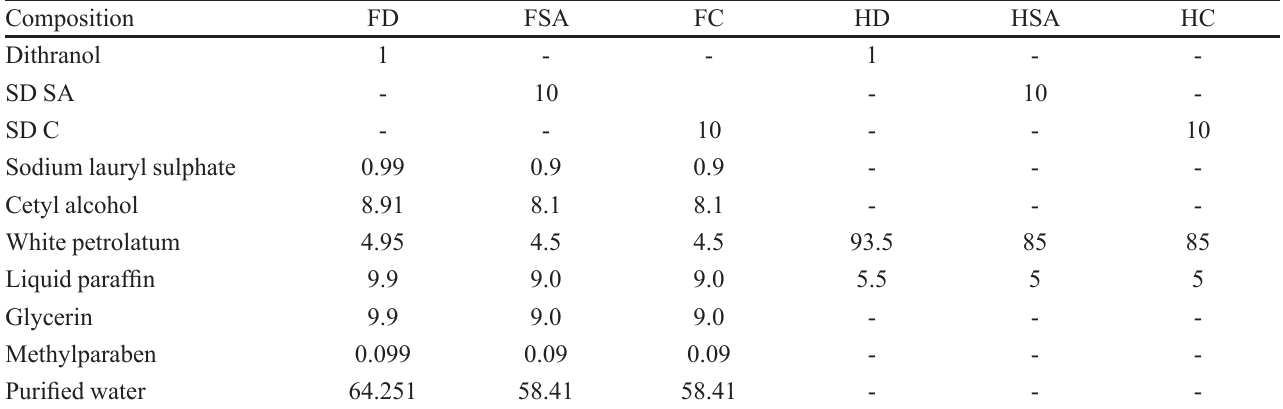
TABLE I – Composition of different formulations with dithranol, SD of dithranol in stearic acid and argan oil (SD SA) and SD of dithranol in glyceryl behenate (SD C). FD, FSA and FC corresponds to the O/W cream with pure dithranol, SD SA and SD C, respectively; HD, HSA and HC, corresponds to the hydrophobic ointment with pure dithranol, SD SA and SD C, respectively